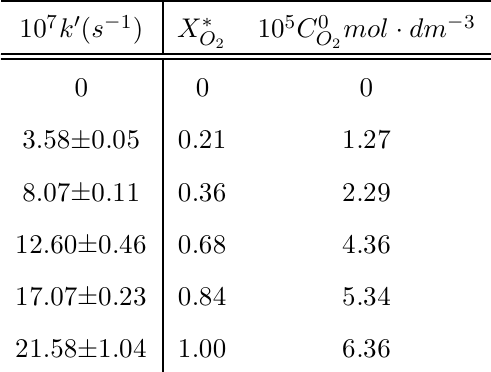
Table 2 Variation of pseudo-› rst order rate constant vs . initial concentration of O 2 at pH 7.45 and 25¸C * Molar fraction of O 2 in input